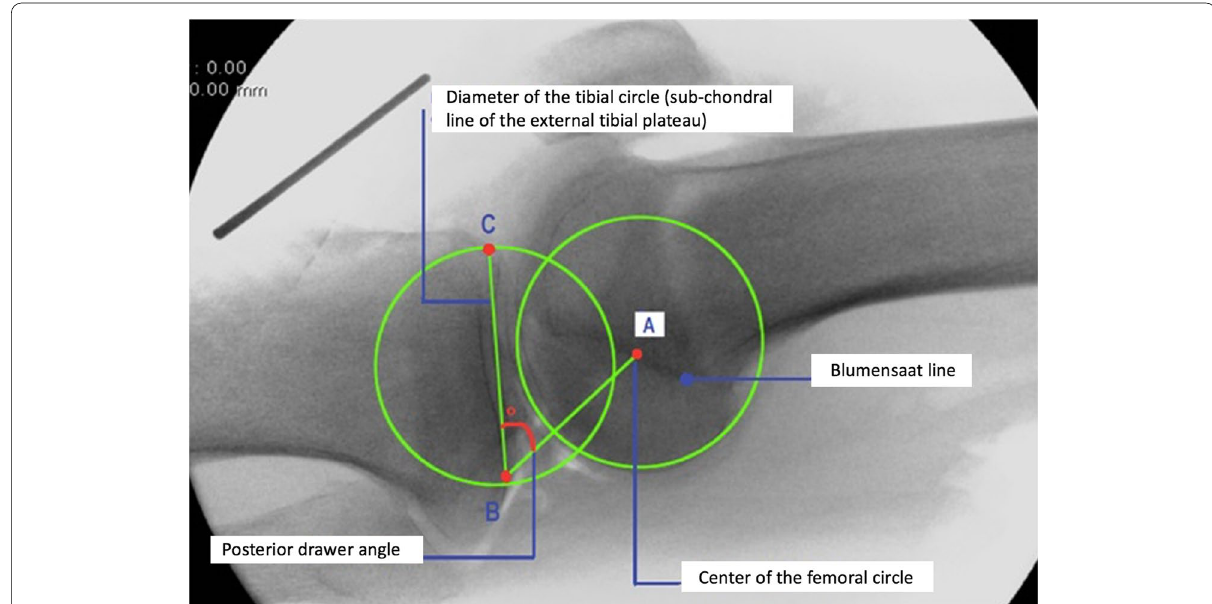
Fig. 2 A set of control lateral radiographic images of the knee were made by fluoroscopy with the cadaver knee in 0°, 45° and 90° flexion. Radiographic image of the knee in extension with posterior stress. (Point A: Center of first circle (defining the knee’s center of rotation), Point B: Posterior end of the second circle’s diameter, Point C: Anterior end of the second circle’s